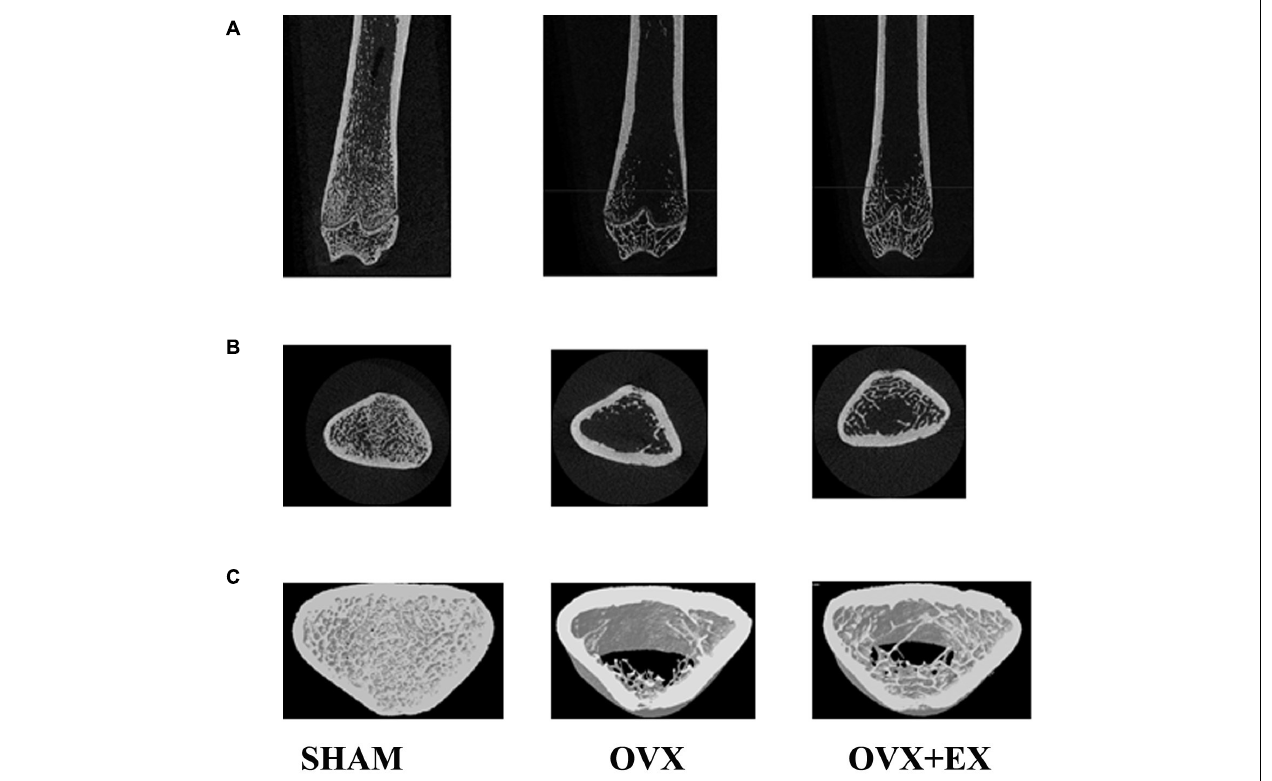
FIGURE 2 | Two-dimensional structure of the longitudinal and transverse sections of the distal femur and the three-dimensional reconstruction of cancellous bone of the distal femur in the region of interest (A) the longitudinal section of the distal femur. (B) The transverse section of the distal femur. (C) 3Drec-onstruction of bone. Representative micro-CT pictures are